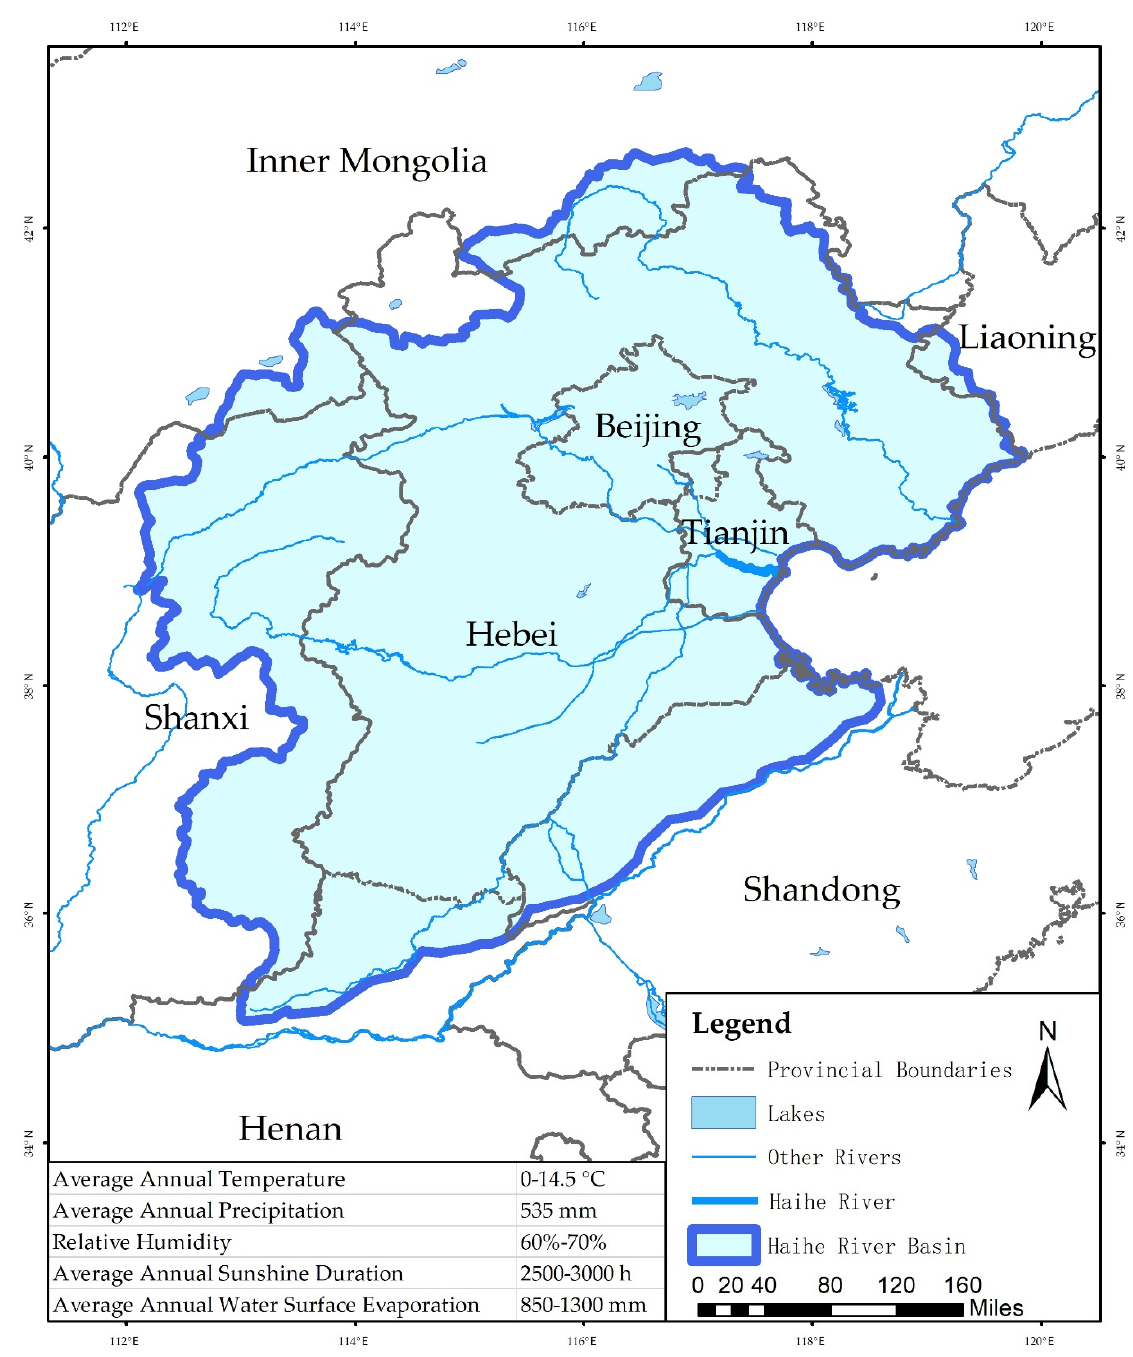
Figure 1. Haihe River Basin geography and administrative divisions chart.